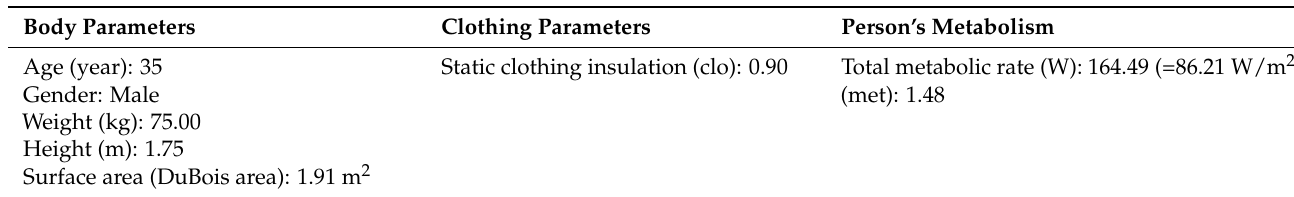
Table 3. Personal human parameters (according to “Standard human” ISO7730).